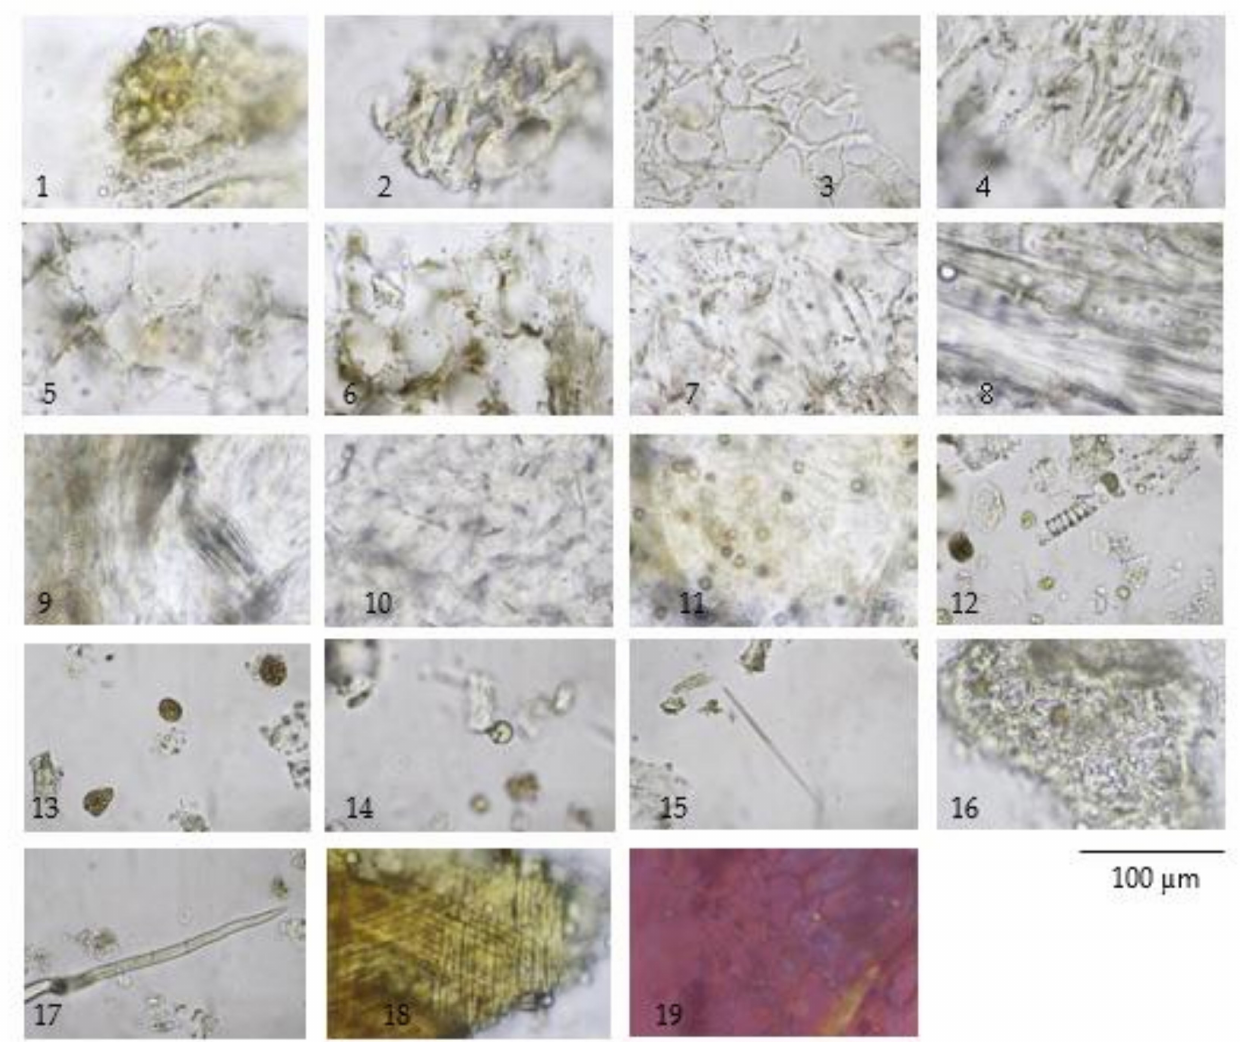
Figure 4. Diagnostic characteristics of Morinda citrifolia L. fruit powder: ( 1 ) epicarp; ( 2 – 4 ) thickening-walled parenchyma from fruit pulp in cross-sectional view ( 2 , 3 ) and longitudinal view ( 4 ); ( 5 – 7 ) thin-walled parenchyma in cross-sectional view ( 5 , 6 ) and longitudinal view ( 7 ); ( 8 ) thin-walled parenchyma associated with vascular strand (phloem tissue); ( 9 ) parenchyma with group of raphide and vascular strand; ( 10 ) parenchyma with scattered rod shape crystals; ( 11 ) parenchyma with microspheroidal crystals of calcium oxalate; ( 12 ) spiral vessel; ( 13 ) resin masses; ( 14 ) oil glob- ules; ( 15 ) acicular crystal; ( 16 ) endosperm; ( 17 ) trichome; ( 18 ) fibrous layer of seed coat; and ( 19 ) microspheroidal crystals under polarized